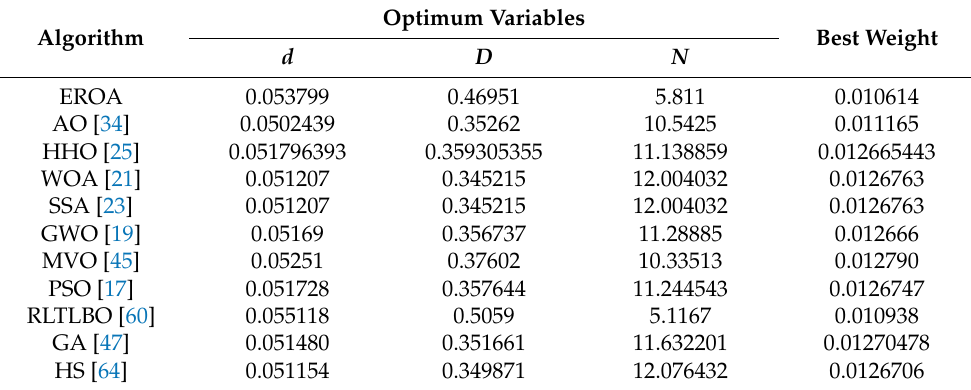
Table 11. Optimization results for the tension/compression design problem.